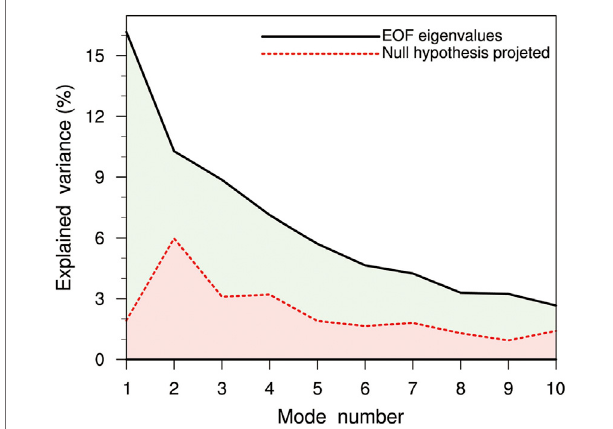
FIGURE 5 | Variance contribution of each mode of the spring 〈 Q 1 〉 EOF (black line) and its contribution to the stochastic null hypothesis (red dashed